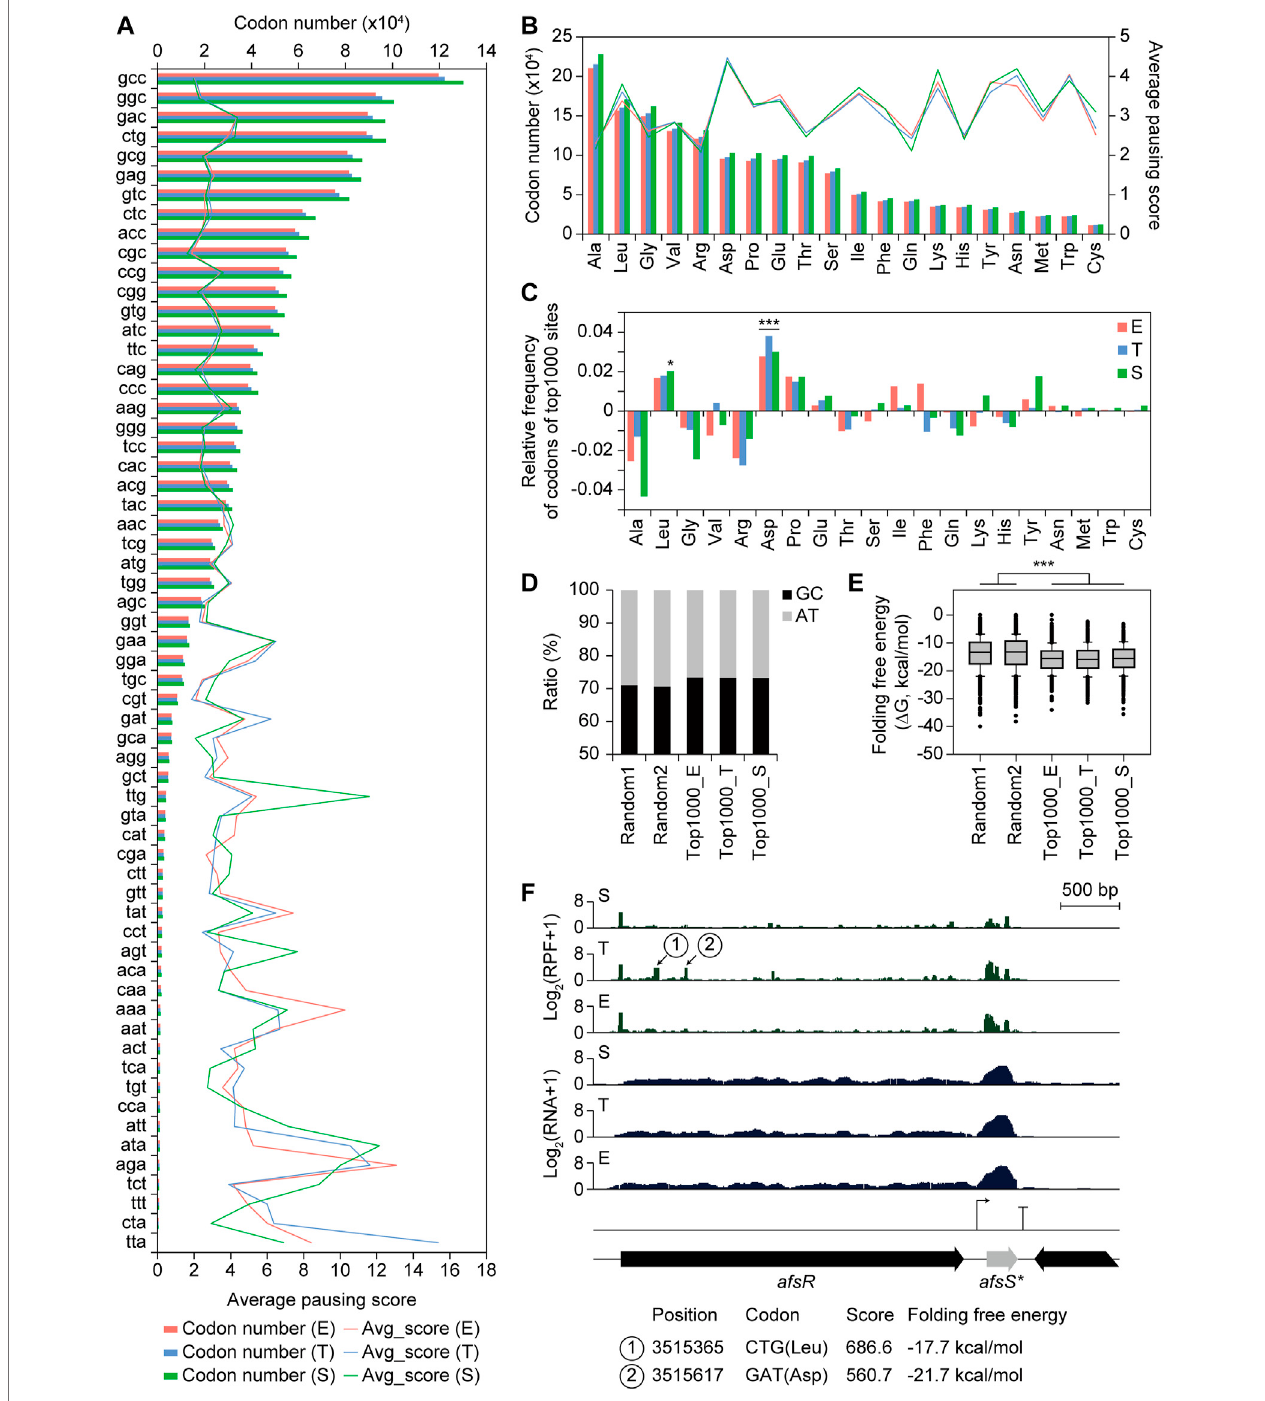
FIGURE 7 | Codon usage and folding free energy of RNA structure affecting translation ef fi ciency. (A) Average pausing score for 61 codons in A site of the ribosome, and their number of each codon. (B) Average pausing score for 20 amino acids in A site of the ribosome, and their number of codons corresponding to each amino acid. (C) Relative frequency of codons corresponding to each amino acid for top 1,000 pausing score sites compared to total sites. Statistical signi fi cance of the ratio was calculated by chi-square test. (*** p < 0.01, and * p < 0.05). (D) GC ratio of the 40 nt downstream sequence from 3 ′ -end boundary of ribosome at the pausing site of the two random position groups within CDS (except ten codons from both ends) and top 1,000 pausing score sites at three different growth phases. (E) Folding free energy of RNA structure of the 40 nt downstream sequence from 3 ′ -end boundary of ribosome at the pausing site of the different groups in (D) . Statistical signi fi cancewascalculatedbyWilcoxonranksumtest.(*** p < 0.01). (F) Apro fi leexampleofpotentialribosomepausingsites.Position,codon,pausingscore,andfolding free energy of RNA structure for the pausing sites were indicated.